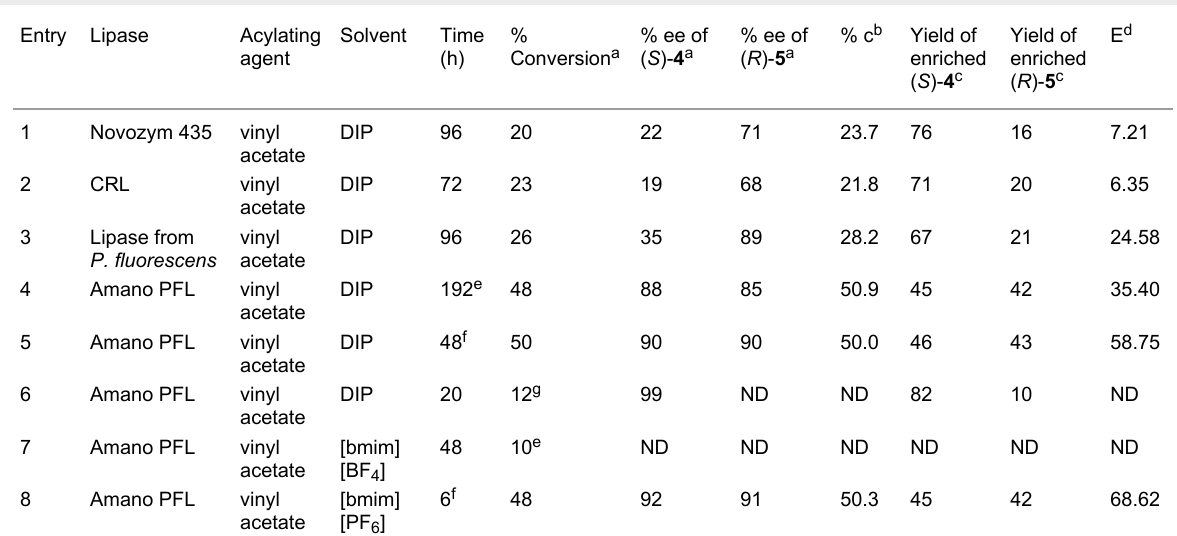
Table 1: Lipase-catalyzed resolution of (±)- 4